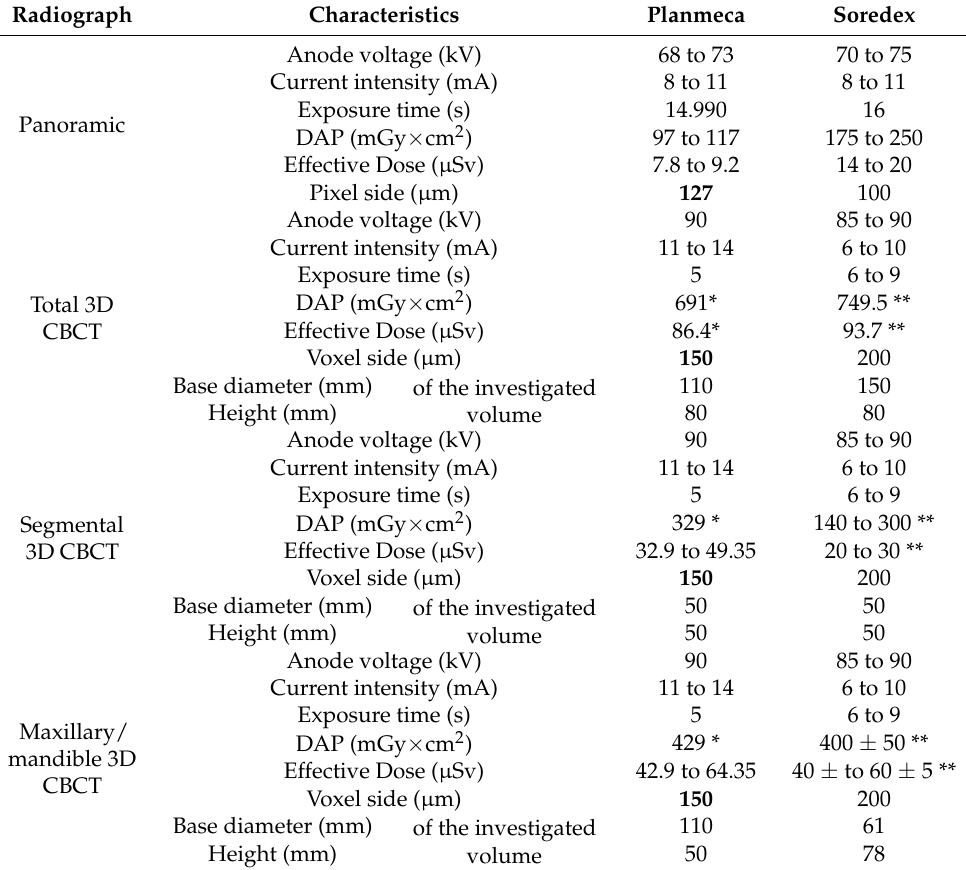
Table 6. Characteristic parameters of panoramic radiographs, as well as total, segmental, and maxillary or mandible 3D CBCT—for the two types of considered X-ray